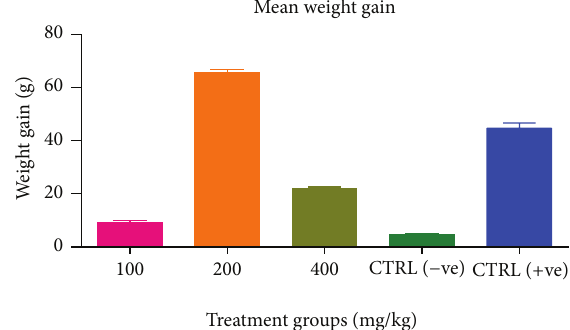
Figure 2: Effect of the combined extracts on weight gain of chickens infected with Eimeria